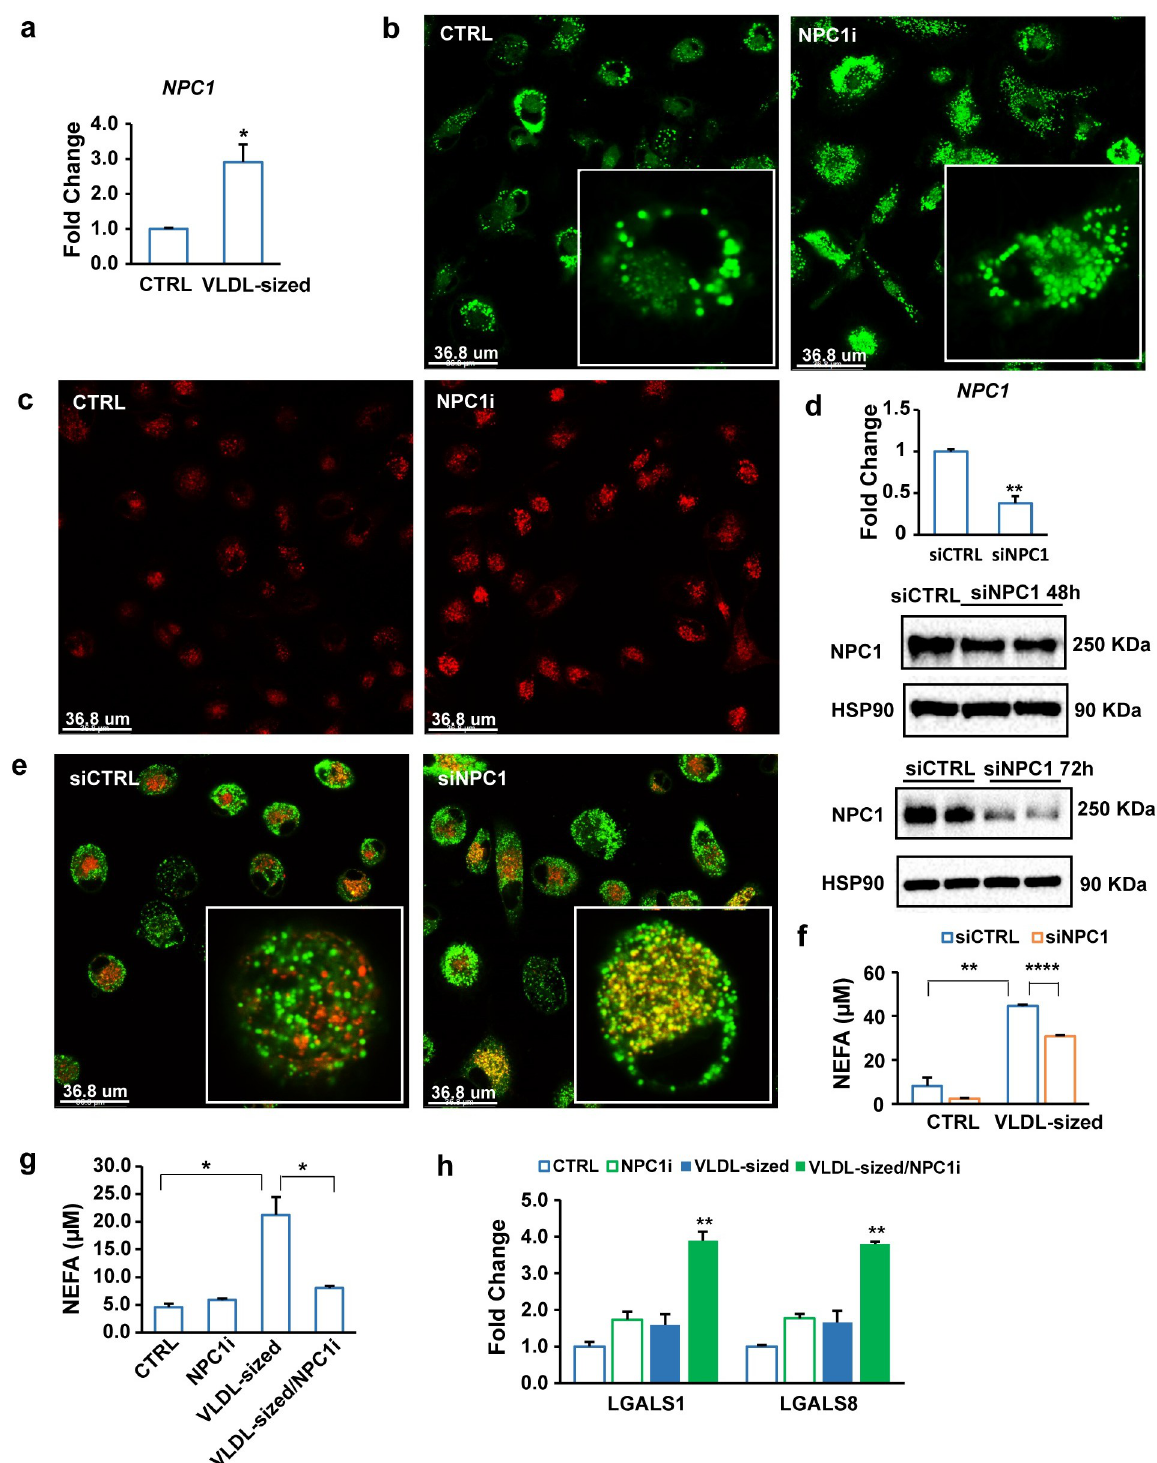
Fig 7. Part of the internalized TG in VLDL-sized emulsion particles is released from macrophages after lysosomal processing. (a) mRNA levels of NPC1 in human macrophages treated with 1 mM VLDL-sized emulsion particles for 6 hours. Cells were washed twice with PBS and then incubated in fresh medium for 16 hours. (b) BODIPY 493/503 staining or (c) lysosomal staining of human macrophages treated with 0.5 mM VLDL-sized emulsion particles for 6 hours in the presence or absence of 5 μ M NPC1 inhibitor U18666A ( n = 6). (d) mRNA and protein